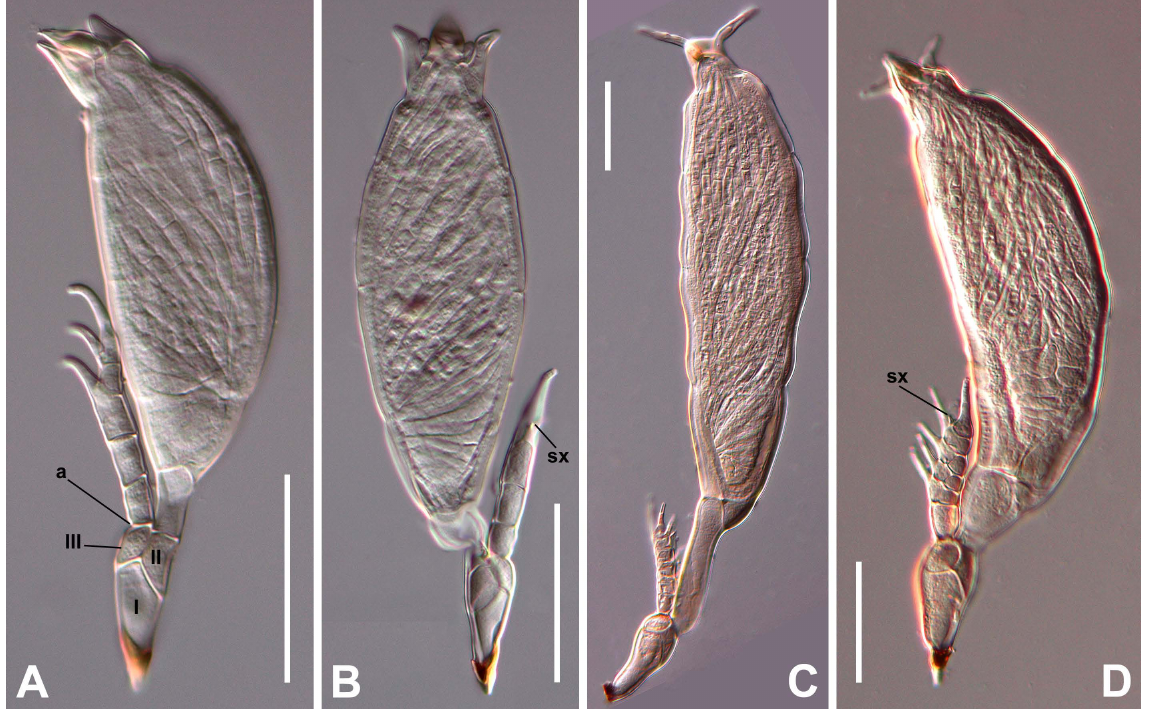
Fig. 53. Hesperomyces spp. A – B . H. coccinelloides (Thaxt.) Thaxt. Mature thalli showing labelled cells I, II, III, primary septum (a), and a spinous process from the original spore apex (sx). – C – D . H. virescens Thaxt . Mature thalli. In D, “sx” corresponds to the spiny original spore apex. Scale bars: 50 µm. Photographs from slides ZMUC C-F-123662 (A–B), ZMUC C-F-124113 (C), ZMUC C-F-124109